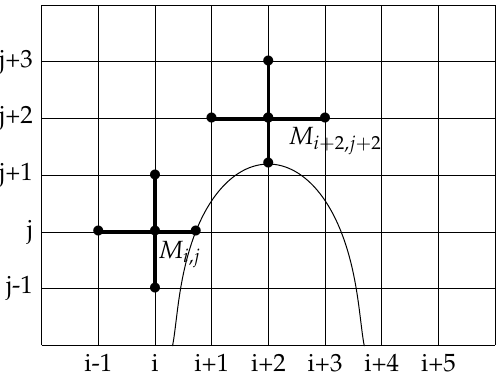
Figure 3. Example of geometrical configuration, with points involved in the discretization of the divergence of the predicted velocity and pressure gradient at grid points M i , j and M i + 2, j + 2 in